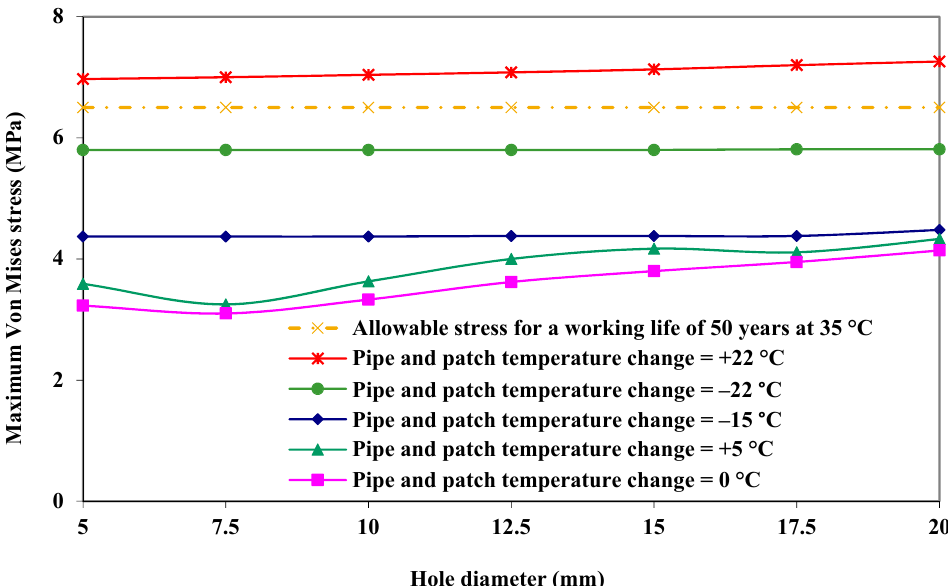
Figure 16. Maximum Von Mises stress in the square partial patch for various sizes of circular hole defects (the simultaneous effect of mechanical and thermal loads).